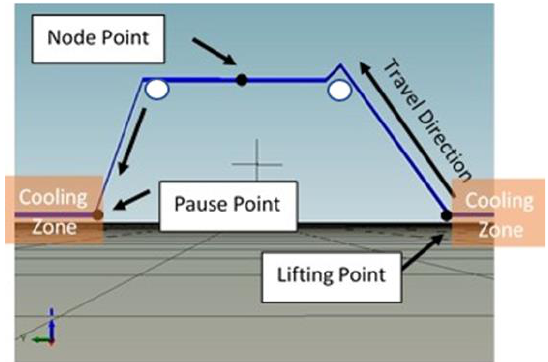
Figure 9. Placement End Effector Path for Navtruss geometry.